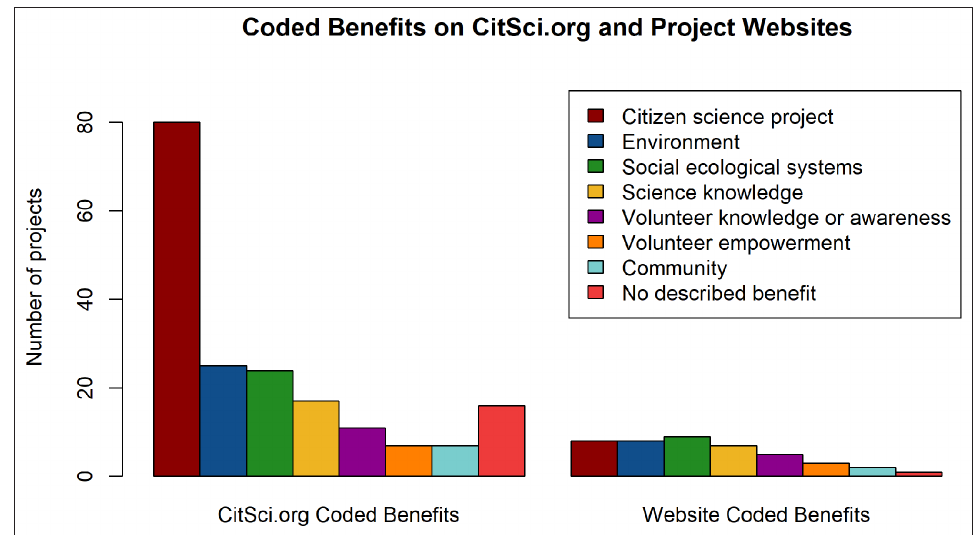
Figure 4: Coded benefits on CitSci.org and project websites. A comparison of who or what benefits from volunteer tasks according to project descriptions on CitSci.org and associated project